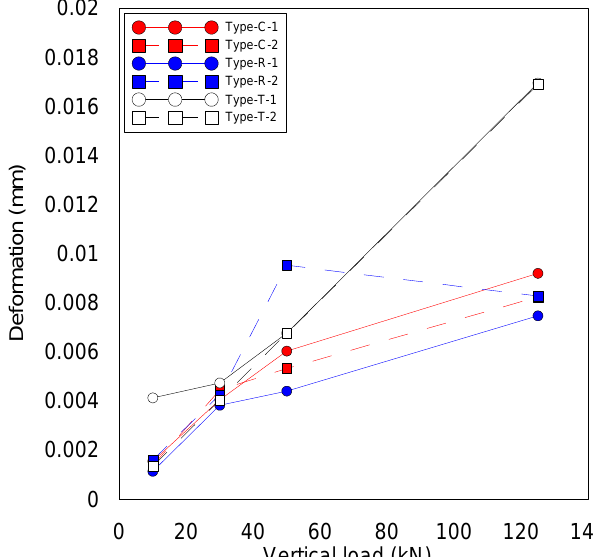
Figure 15. Deformation of sliding plate according to vertical load.